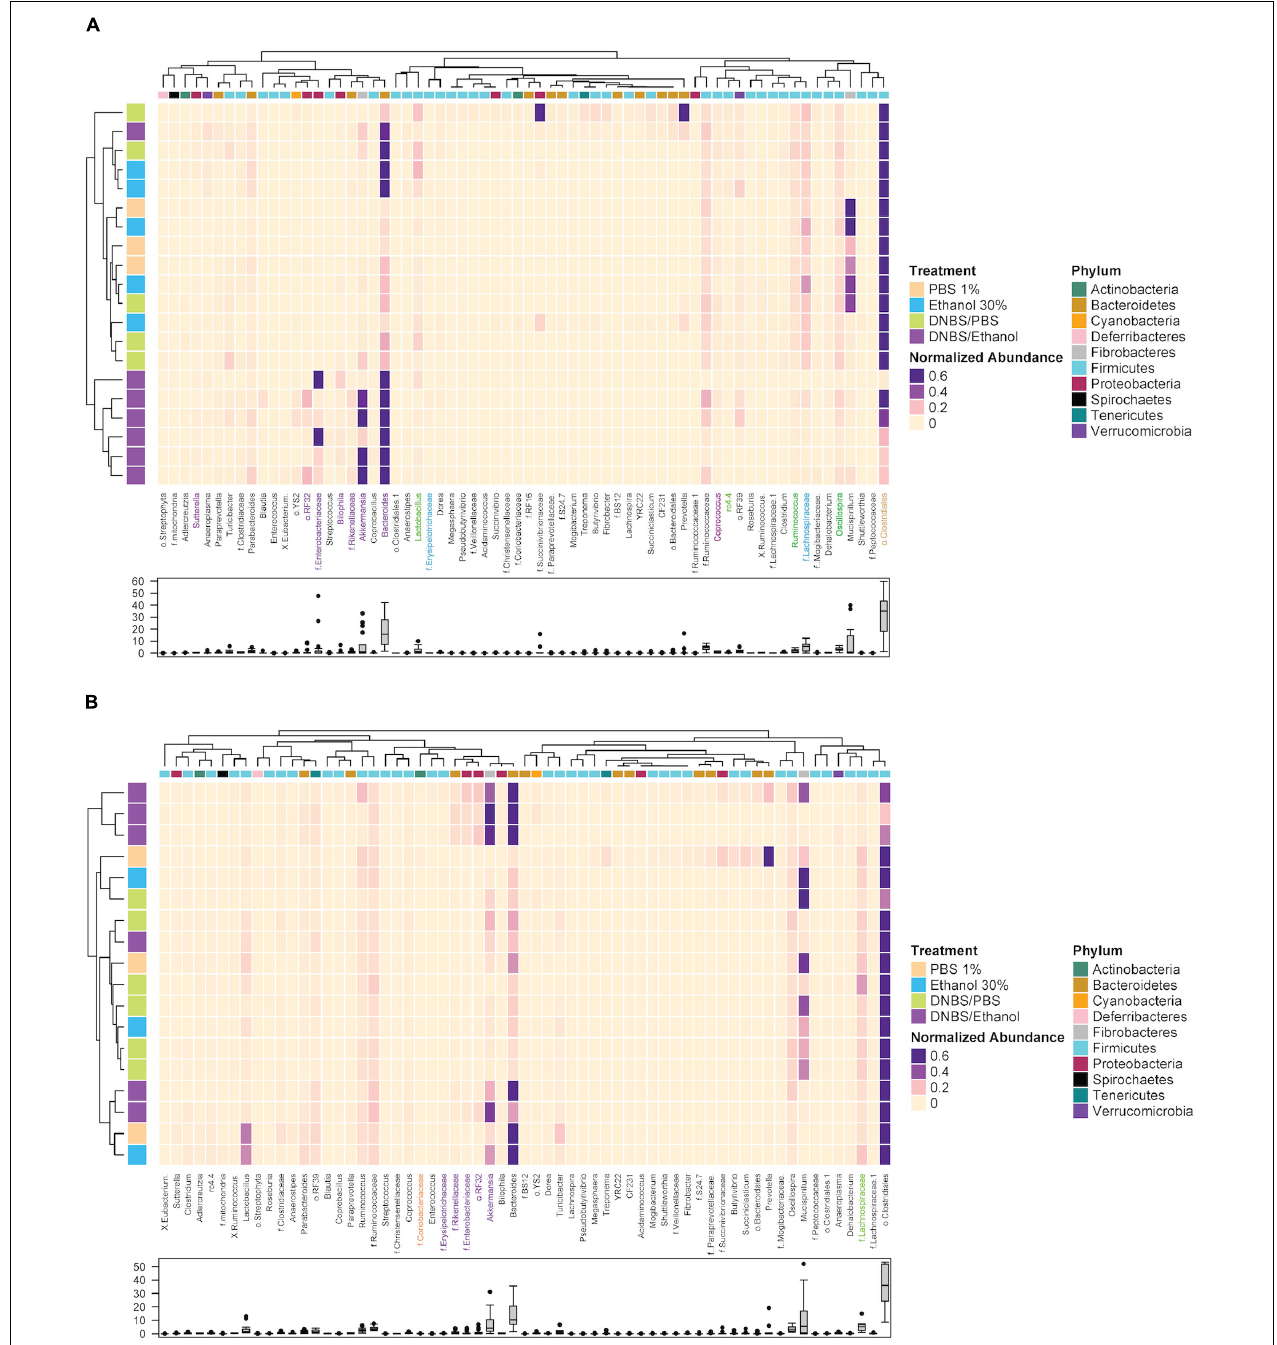
FIGURE 7 | The clustering pattern of colonic and fecal microbial communities of vehicle and denosumab-treated samples. Rows correspond to samples and columns correspond to abundant genera ( > 0.1% of community). The “normalized abundance” key relates colors to the normalized proportions of genera (relative abundance of each genus divided by the Euclidean length of the column vector). The left dendogram shows how samples are clustered based on their Bray–Curtis dissimilarities (using unweighted pair group method with arithmetic averaging UPGMA). The significance of clustering patterns has been calculated based on 9999 permutations and p-values calculated based on PERMANOVA. The top dendogram shows how genera correlate (co-occur) with each other based on their Spearman’s correlation coefficient. The “Phylum” key relates the top annotations to the corresponding phylum of each genus. The “Treatment,” key relates samples to the treatments group (PBS 1%, Ethanol 30%, DNBS/PBS, DNBS/Ethanol). The bottom box-plot shows the distributions of the non-normalized relative abundances of genera in vehicle group (A) and denosumab group (B) . Color codes have been also used to highlight bacterial genera that were significantly associated with treatment groups (colors are in accordance with the colors of treatment groups; p < 0.05).